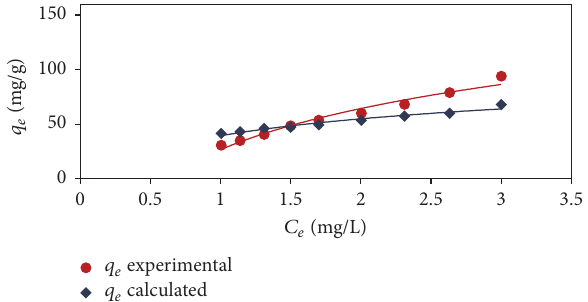
Figure 14: Extended Langmuir model for RR-RB in binary system with RB-5 (temp. = 25 ∘ C, speed = 200 rpm, time = 24 hr., and con. of RR-RB = con. of RB-5 = 100mg/L).